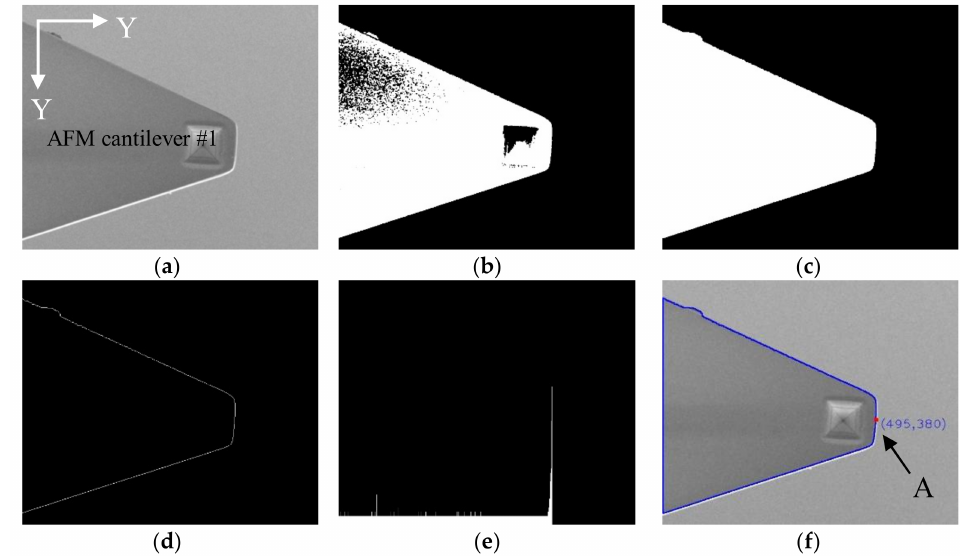
Figure 4. Recognition of AFM cantilever #1. ( a ) Raw image; ( b ) Threshold image; ( c ) Morphological dilation operations; ( d ) Extracting edge contour of AFM cantilever #1; ( e ) Vertical projection of AFM 1 cantilever edge contour along the Y-direction; ( f ) Obtaining a fixed point (A) on AFM cantilever